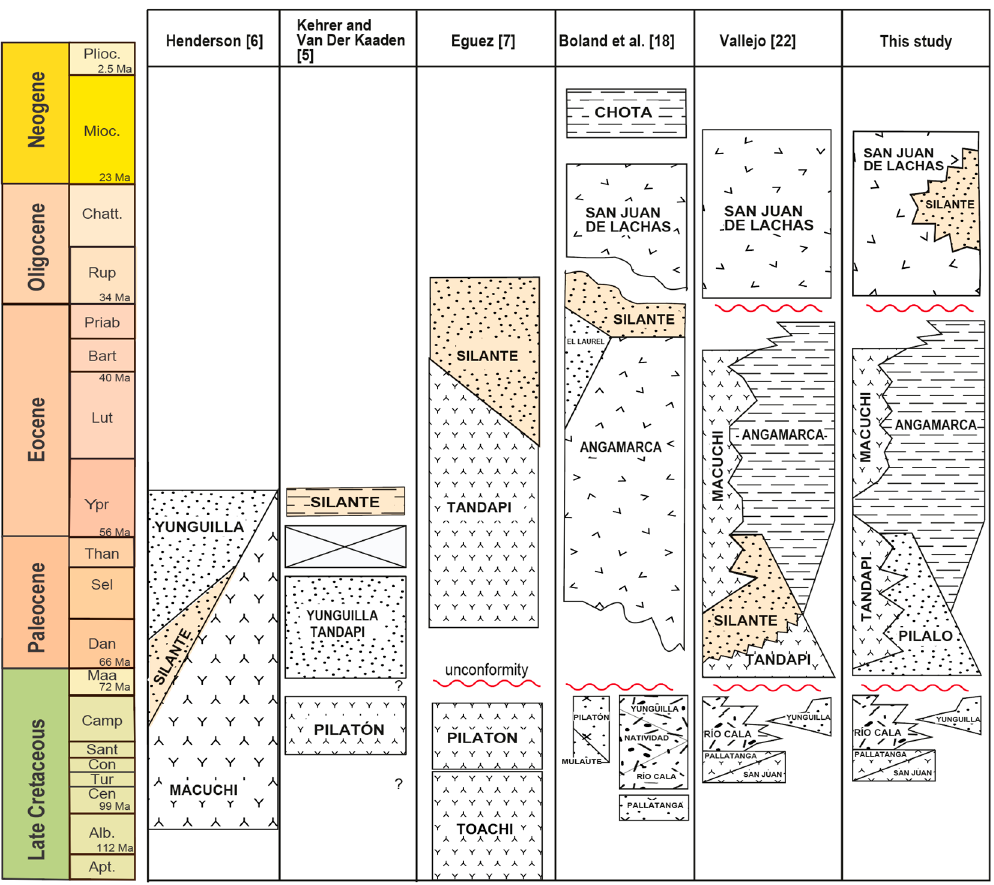
Figure 3. Stratigraphic position of the Silante Formation according to different authors [5–7,18,22]. Time scale from Cohen et al. [39].